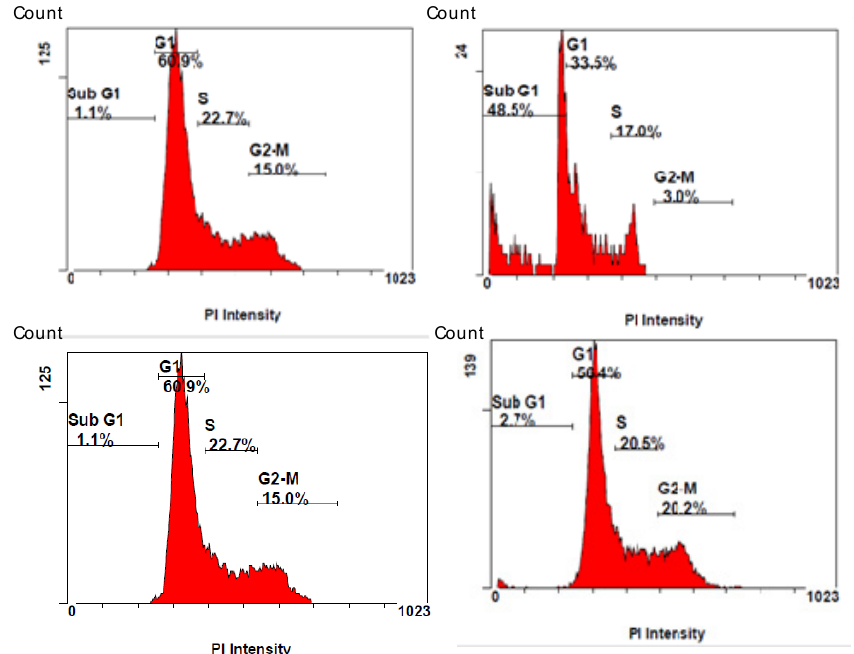
Figure 4. Effect of compounds garcinamine D ( top ) and garcinamine E ( bottom ) on the cell cycle distribution of A549 cells. After treatment with the IC 50 concentration of garcinamine D ( right ); Untreated ( left ). Distribution of cell cycle phases was performed after 48 h of treatment and was quantitated based on flow cytometric analysis.